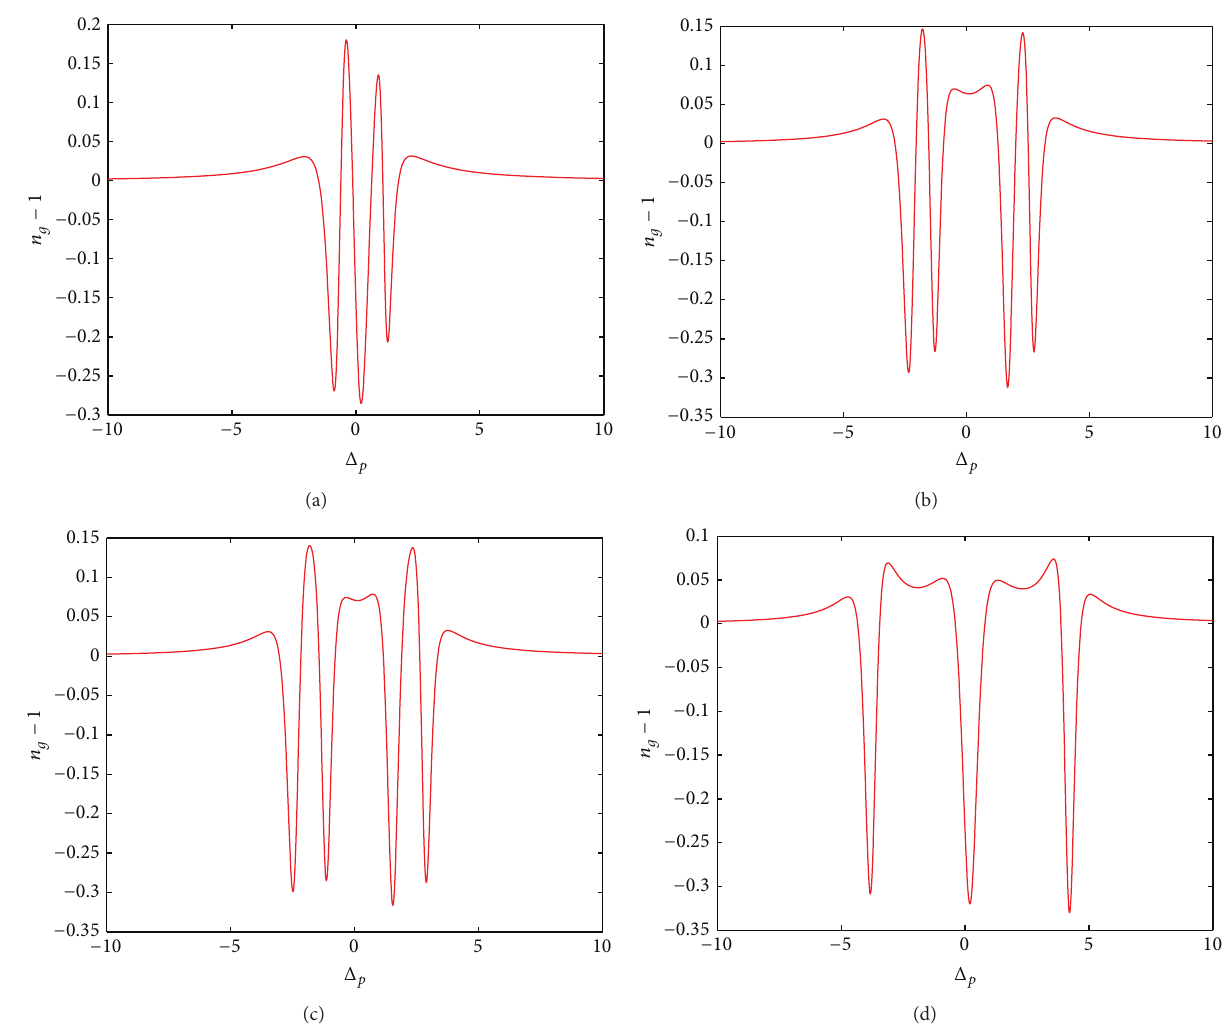
Figure 4: Group index versus probe field detuning. The selected parameters are (a) 𝑇 1 = 𝑇 2 = 0.5 meV; (b) 𝑇 1 = 2 meV, 𝑇 2 = 0.5 meV; (c) = 0.5 meV, 𝑇 = 2 meV; (d) 𝑇 = 𝑇 = 2 meV. The other parameters are the same as in Figure 𝑇 1 2 1 2